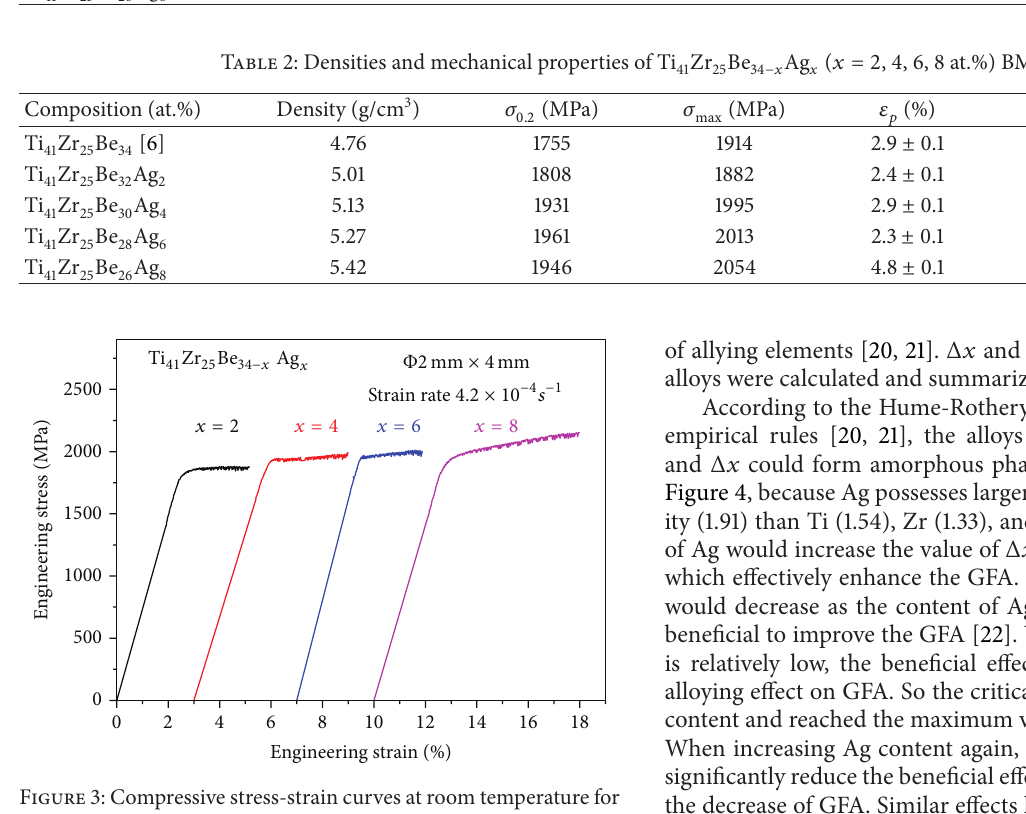
0 kJ/mol, − 20 kJ/mol, − 30 kJ/mol, 2 kJ/mol, and − 43